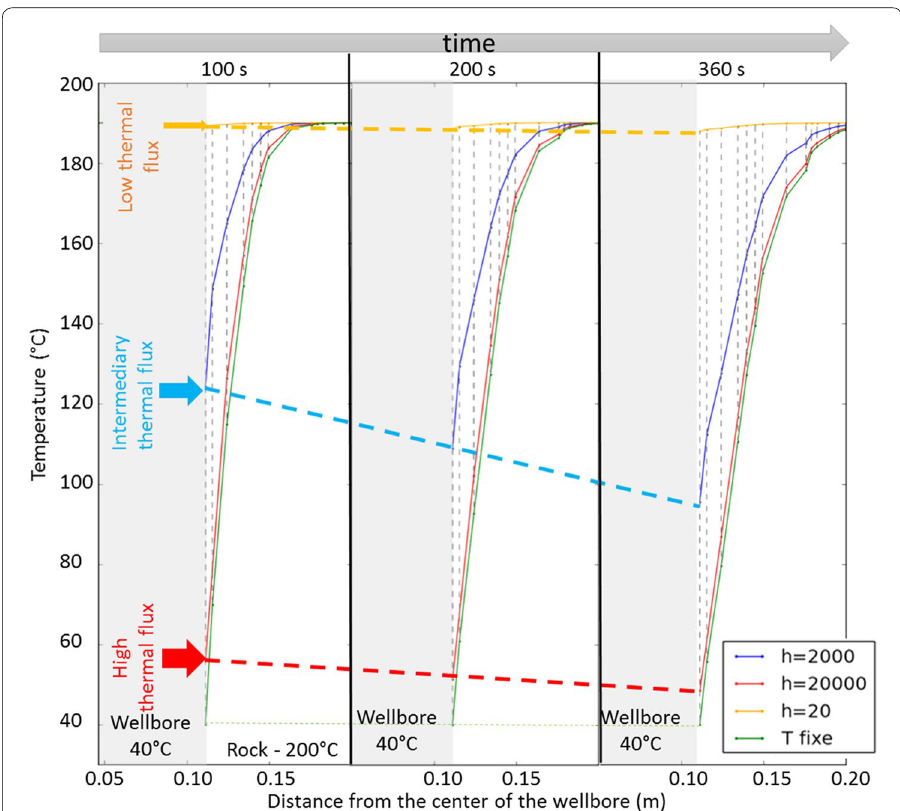
Fig. 6 Examples of the temperature gradient in a rock for different heat transfer coefficient (h, from 20 W m − 2 K − 1 to 20,000 W m − 2 K − 1 ) inducing different heat flux, and evolution with the time. In this example (corresponding to a different numerical setting), the rock temperature is 200 °C and the wellbore fluid temperature is 40 °C. As a matter of comparison, the green curves ( T fixed) present the thermal gradients obtained by setting directly the temperature of the particles of the wellbore at the target temperature (used in the analytical model, see